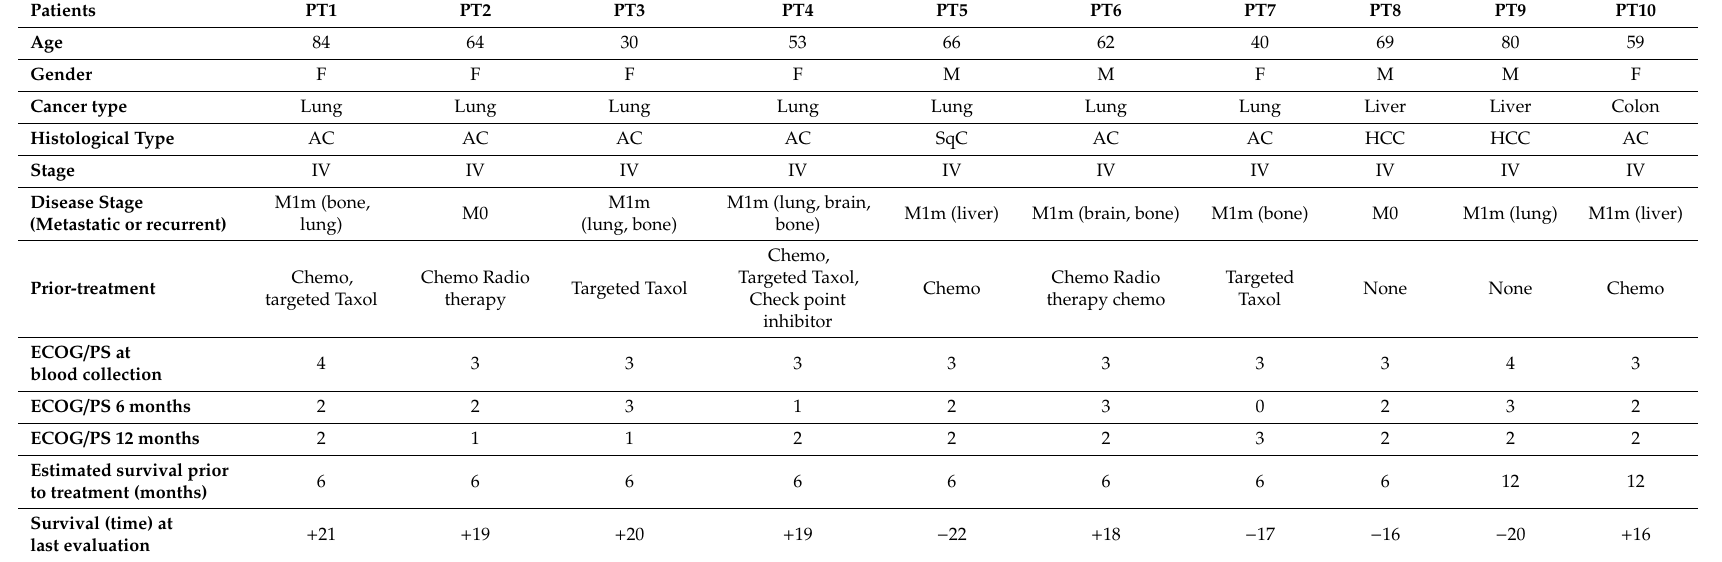
Table 1. Clinicopathological data of the lung cancer patients enrolled in the